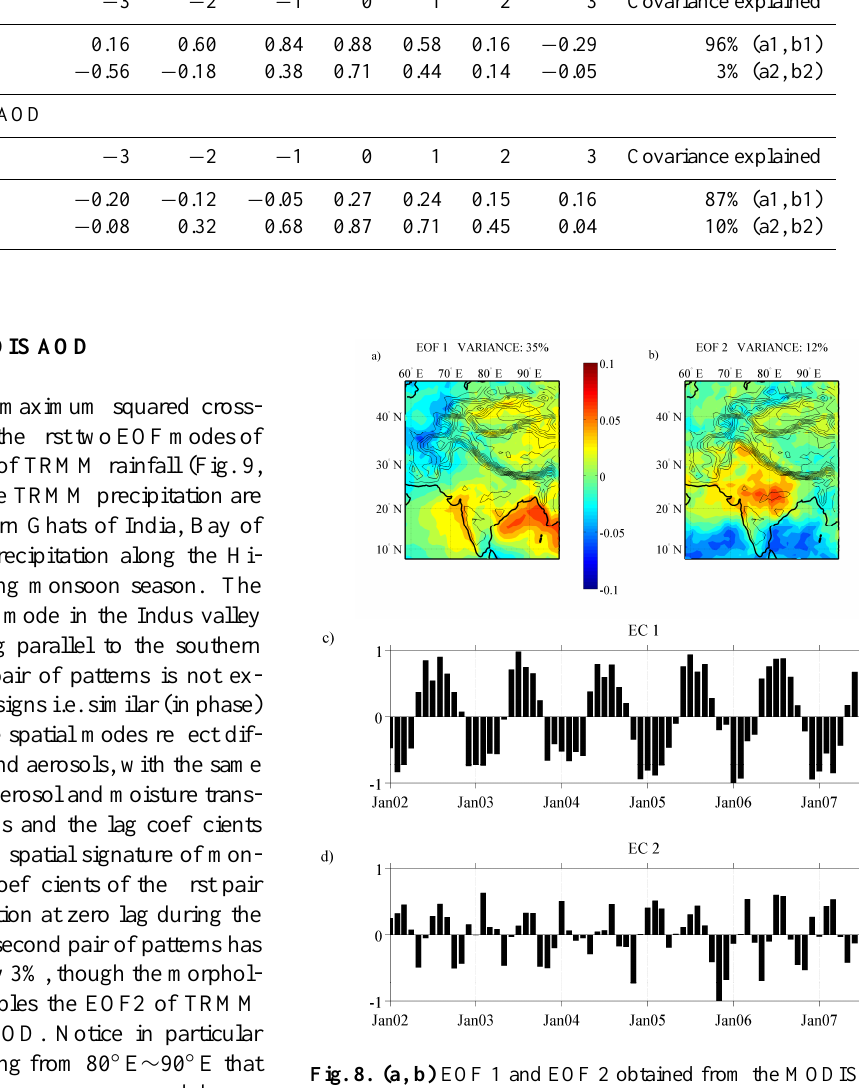
Table 2. Cross-correlation between the expansion coefficients of the pair of patterns TRMM Precipitation-MODIS AOD. Lag − 3 − 2 − 1